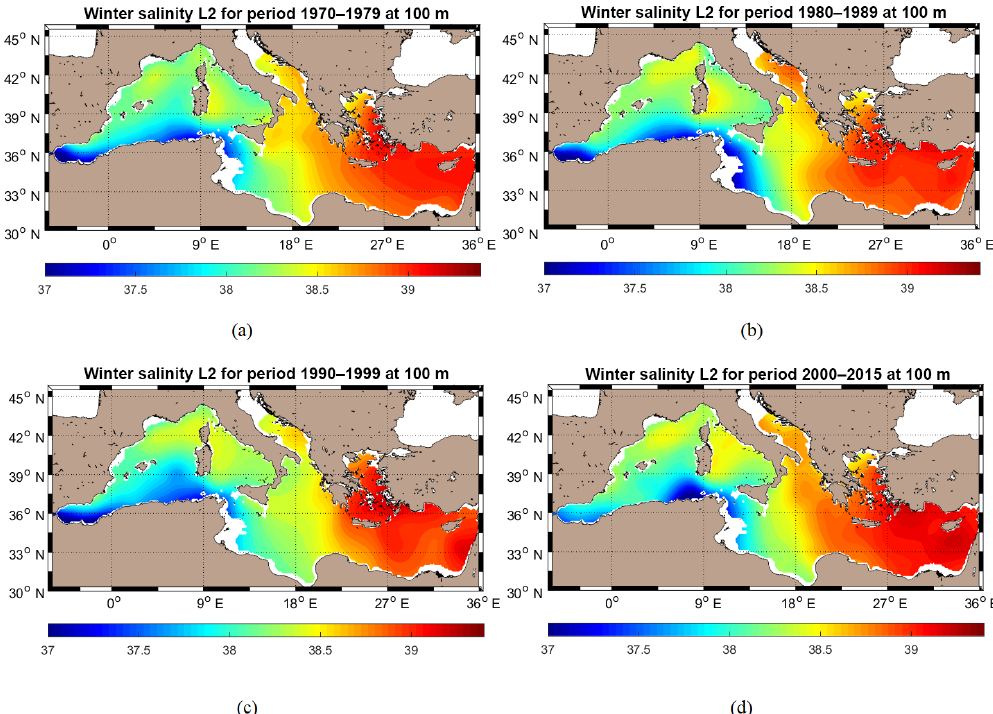
Figure 7. Winter salinity at 100m for four periods: (a) 1970–1979, (b) 1980–1989, (c) 1990–1999, (d) 2000–2015.